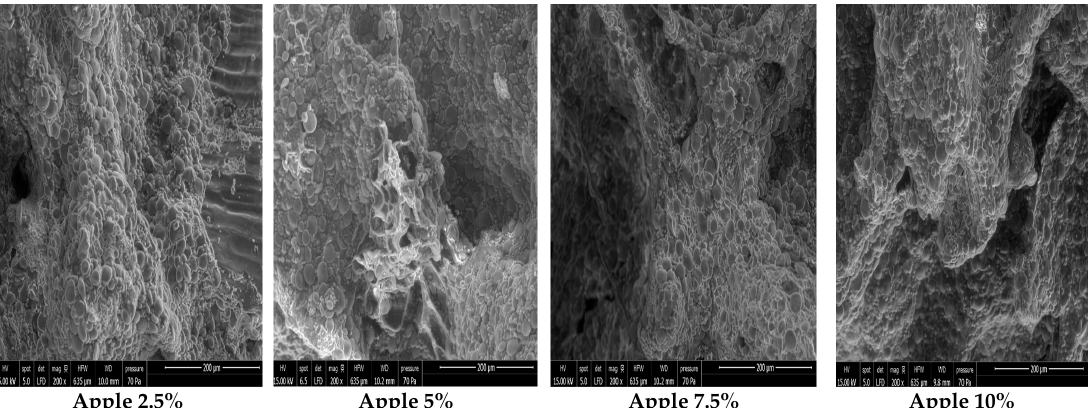
Figure 1. Scanning electron microscopy of dough enriched with date, apple, and pear by-products.